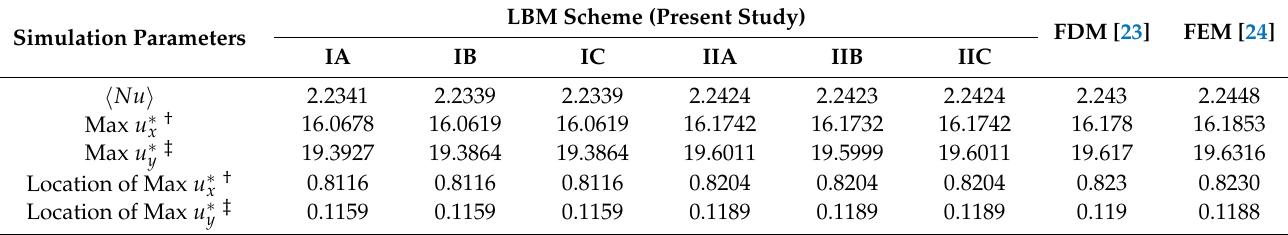
Table 3. Steady-state properties of two-dimensional natural convection in a differentially-heated cavity for Ra = 10 4 , Pr = 0.71, τ υ = 0.6, and Ma = 0.1, compared with solutions of finite difference method (FDM) [23] and finite element method (FEM)